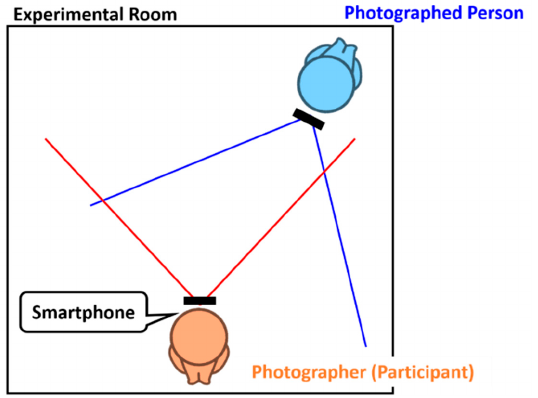
Figure 6. Ideal FRR–FAR curves image and EER crossing